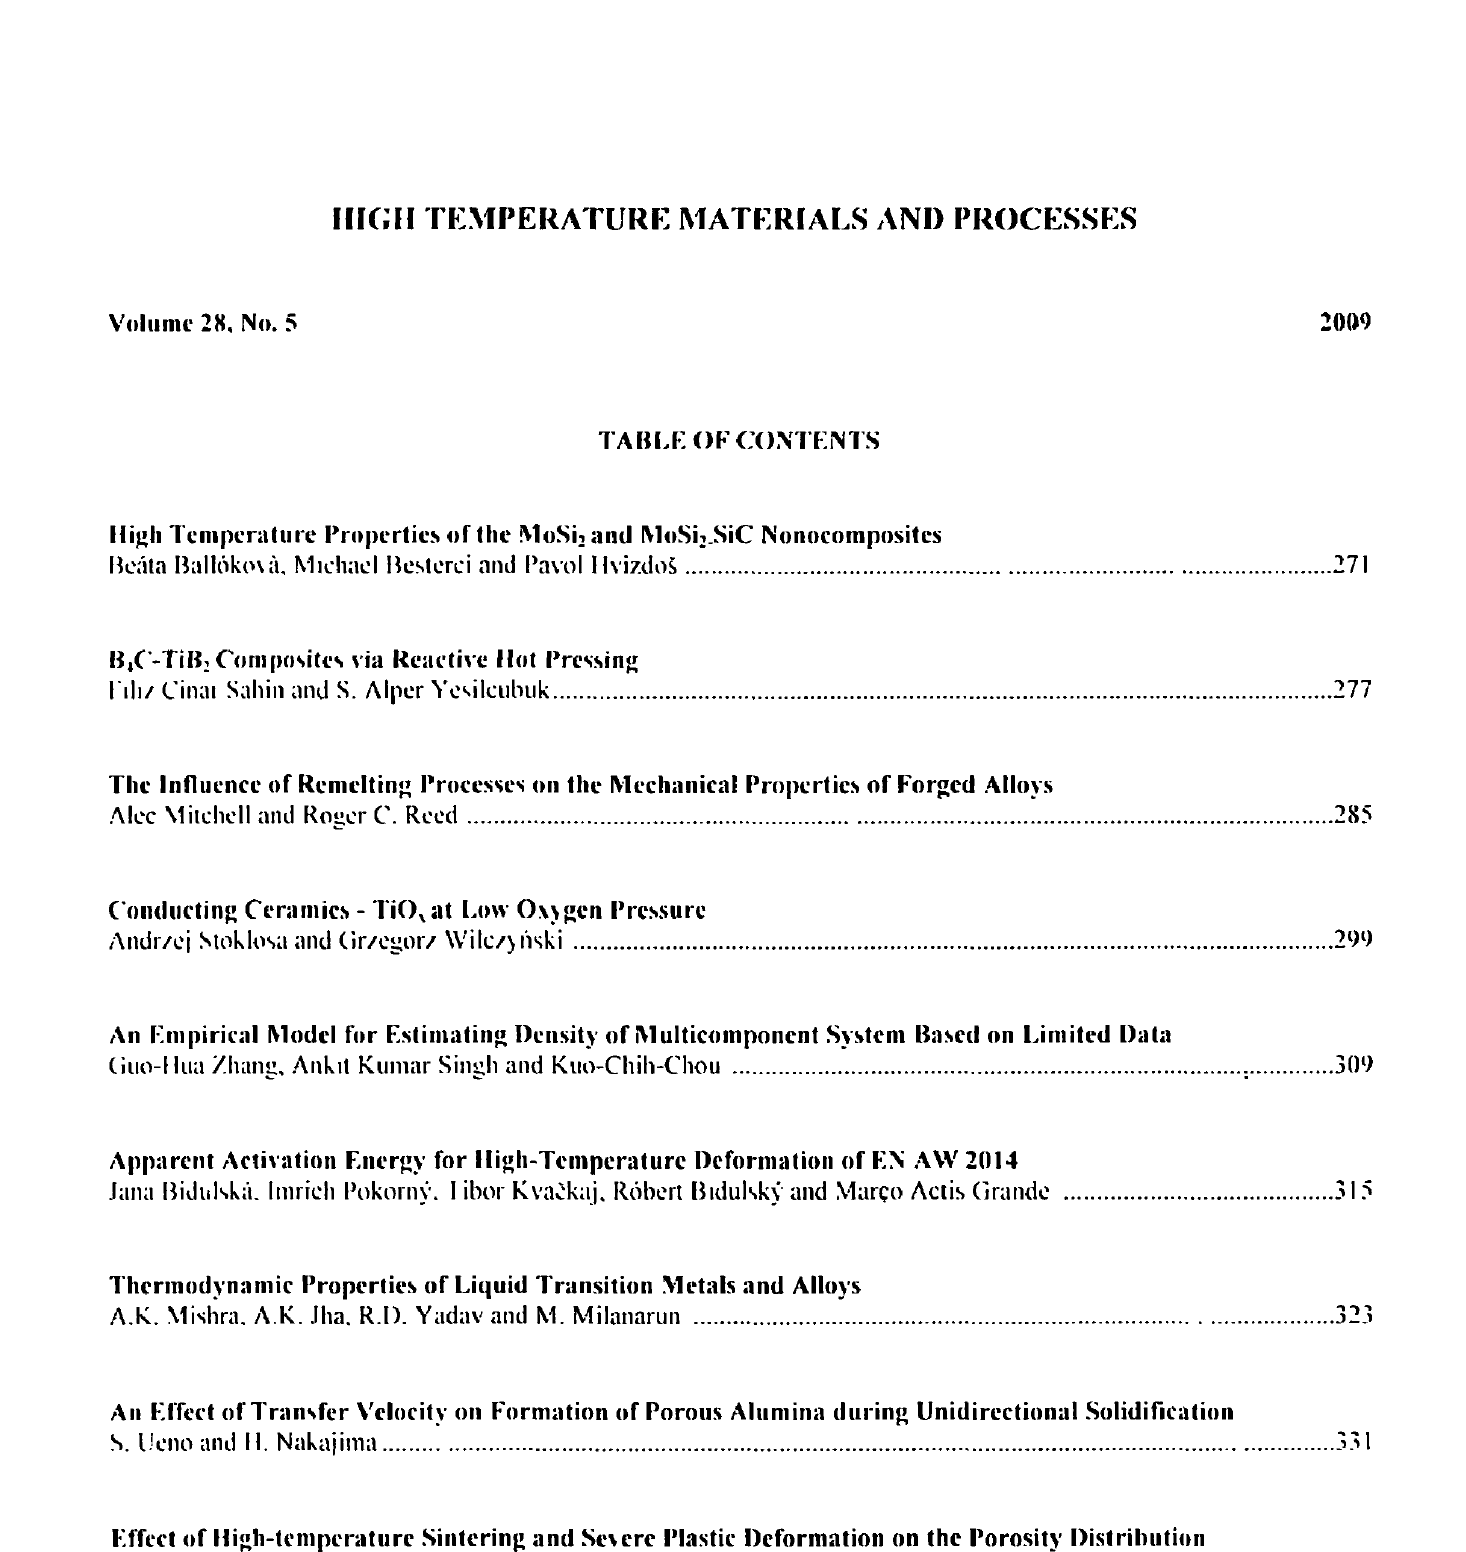
and MoSi .SiC Nonocomposites 2 :